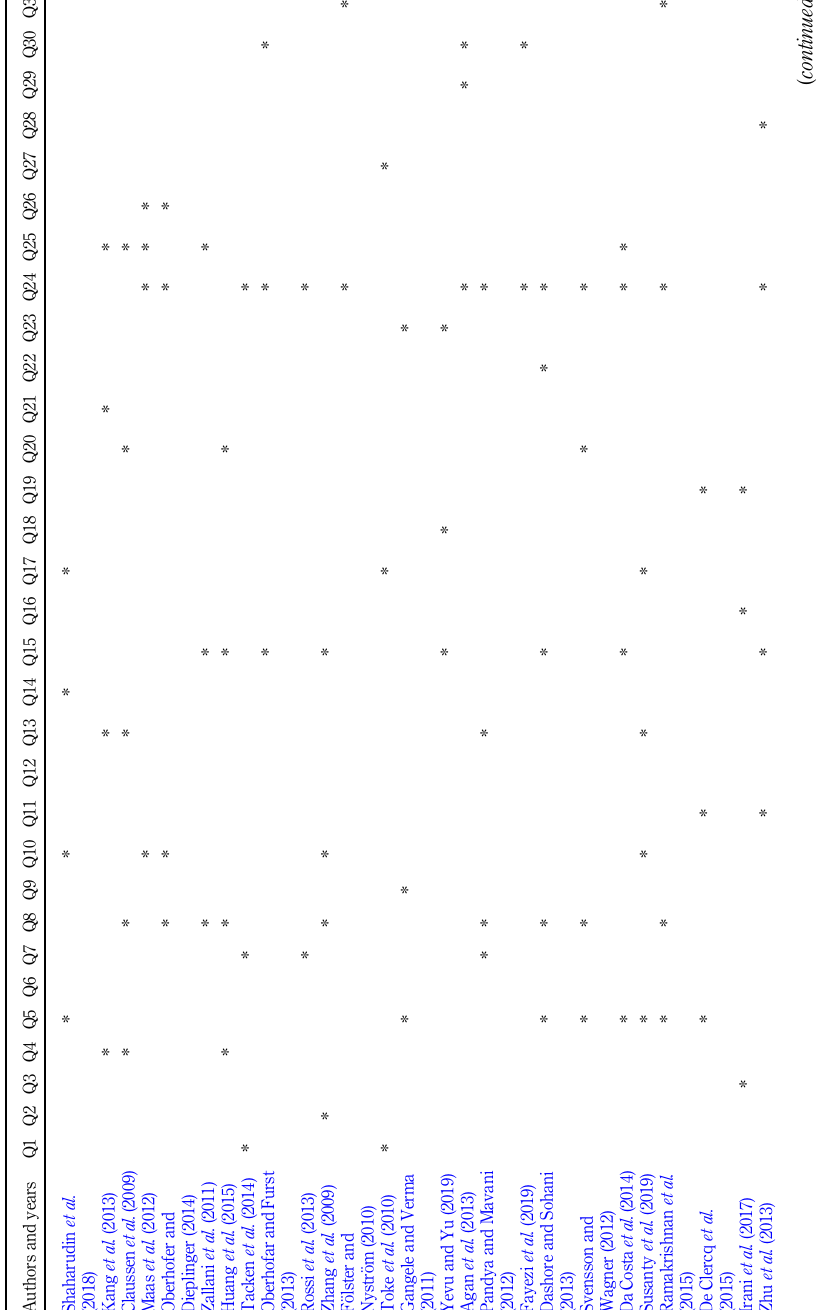
Table 3. Name of authors and the drivers identified in their